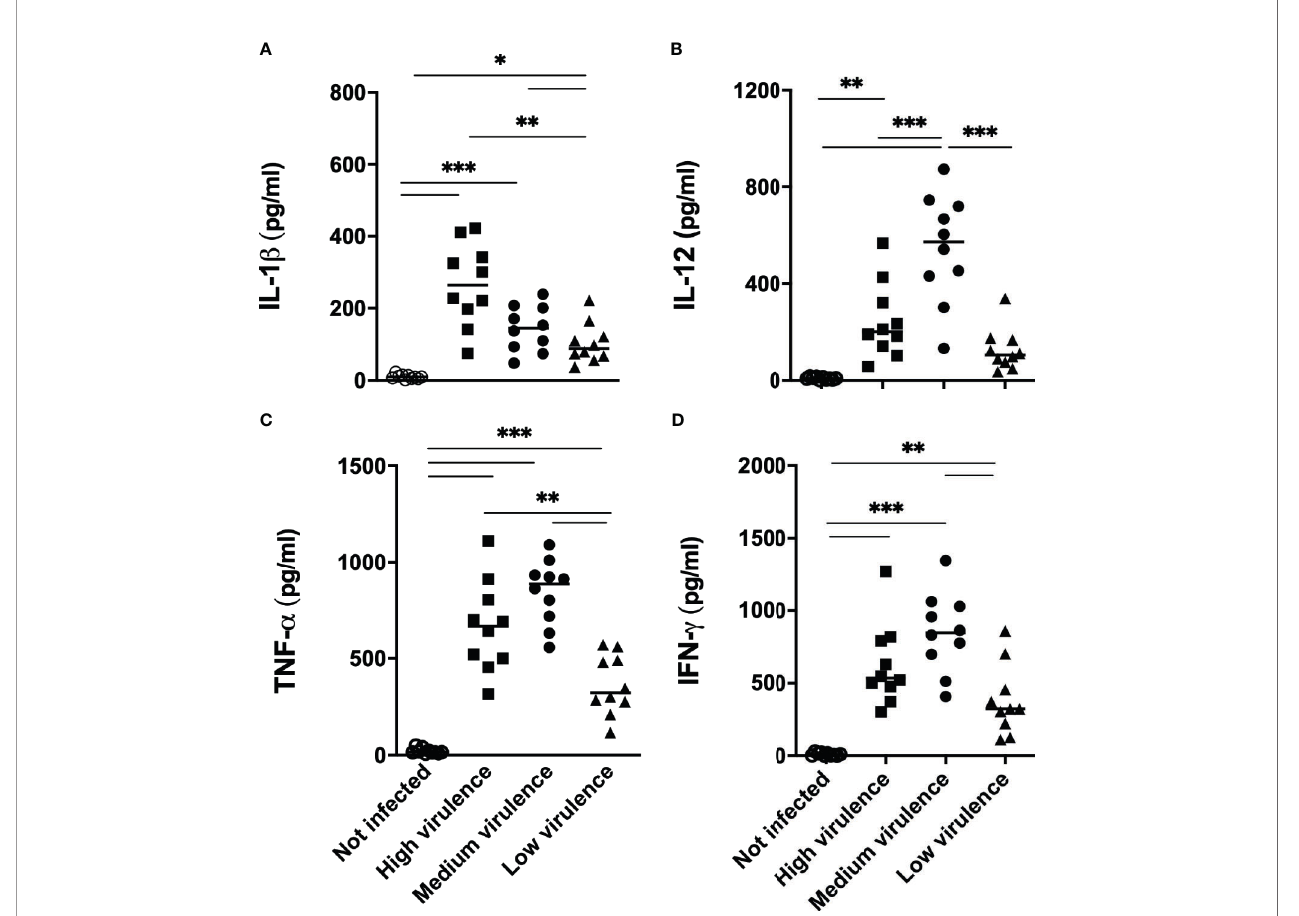
FIGURE 8 | IL-1 b and TNF- a in sera from mice infected with Trypanosoma cruzi are correlated with strain virulence (parasitemia, survival, and myocarditis). IL-1 b (A) , TNF- a (B) , IL-12 (C) and IFN- g (D) were quanti fi ed in the sera (15 days after infection) by ELISA from Swiss mice infected by the intraperitoneal route with 1 × 10 4 blood trypomastigote forms of T. cruzi strains that showed low (AM64 + 3253) (n = 10), medium (PL1.10.14 + CL) (n = 10), and high (Colombian + Y) (n = 10) virulence. The results are expressed as the means ± standard errors. * p < 0.05; ** p < 0.01; *** p < 0.001. UC, uninfected control mice (n =